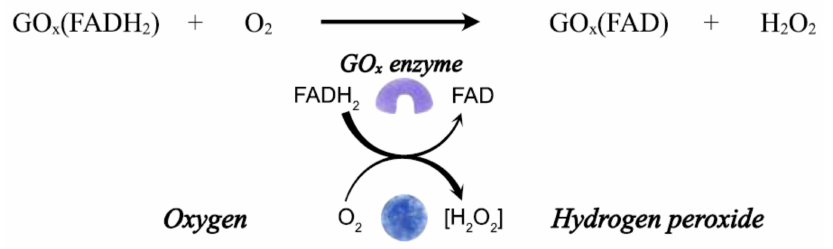
Figure 3. Reduction of GO x (FADH 2 ) by O 2 for first-generation glucose